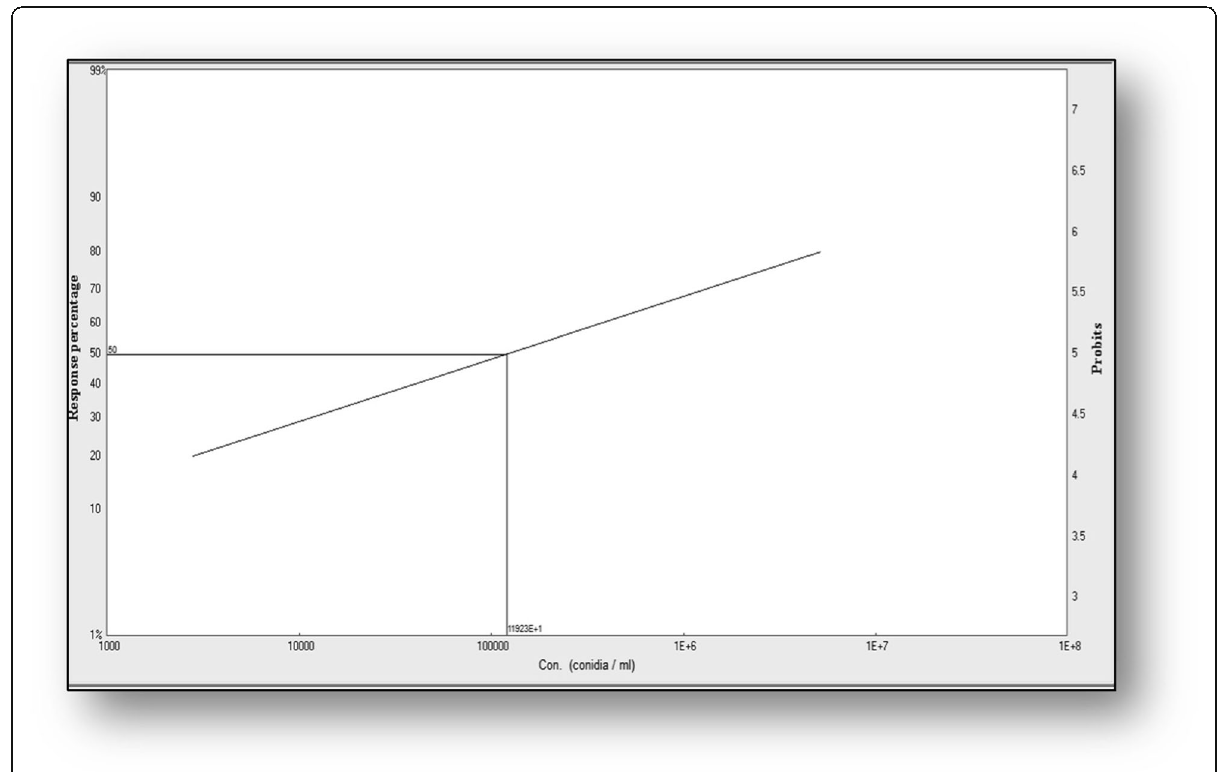
Fig. 1 Concentration-mortality probit lines of Beauveria bassiana against the second-instar larvae of Galleria